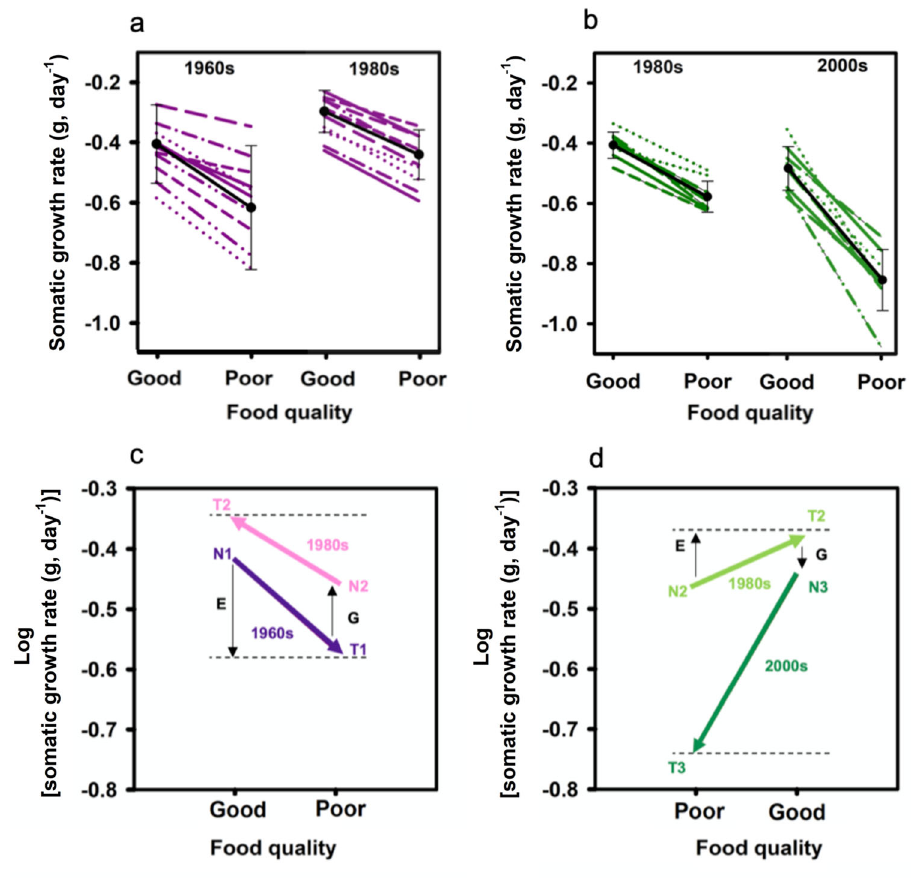
Fig. 2 Reaction norms and counter-gradient variation. Reaction norms of Daphnia (log transformed juvenile somatic growth rates) as a function of food environment (good and poor food; ( a ) data from Hairston et al. 12 (1960s n = 10 biologically independent genotypes; 1980s n = 10 biologically independent genotypes) ( b ) this study (1980s n = 8 biologically independent genotypes; 2000s n = 9 biologically independent genotypes; one-way ANOVA on slopes, F 1,16 = 0.22, p = 0.65). Each line depicts one genetically distinct genotype (purple and green for ( a ) and ( b ), respectively). Black lines depict the